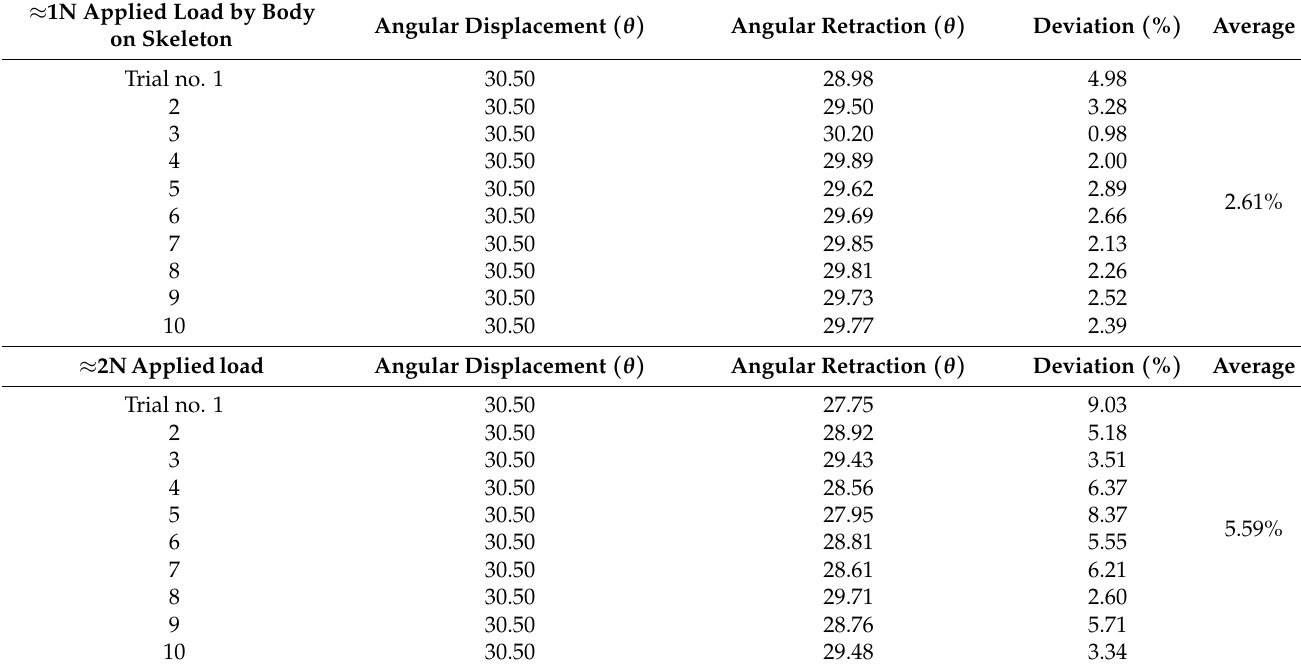
Table A2. Measured angle ( θ ) and deviation (%) with respect to 1 N–2 N applied load by body on skeleton.